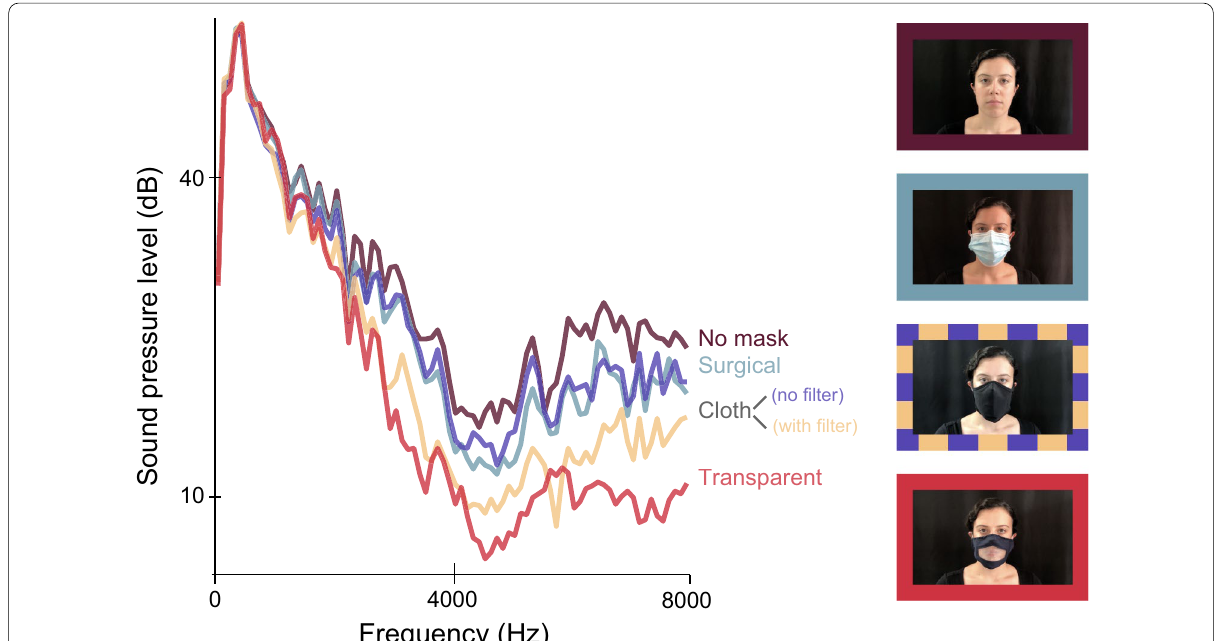
Fig. 1 Average acoustic spectra across all sentences in each mask condition and example images of the talker in each condition. Note. The cloth mask looked the same with or without a